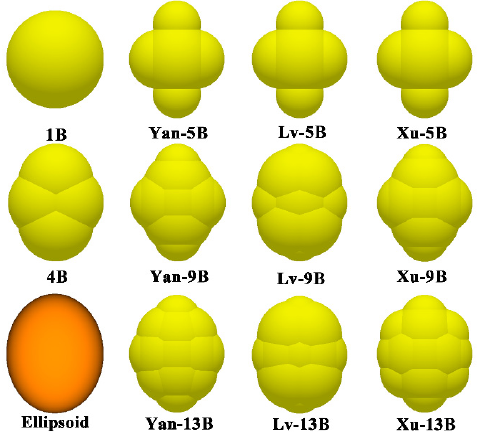
Figure 5. Comparison of models established by different approaches for one single soybean particle of Z-39.